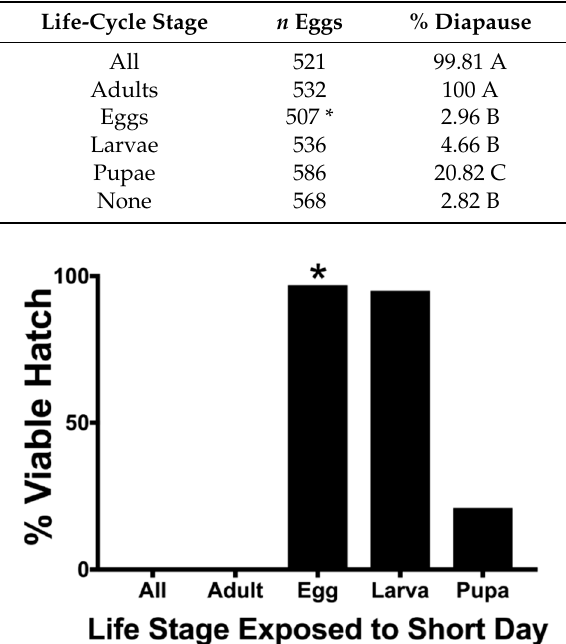
Figure 2. Effect of a short-day photoperiod (8 L:16 D) on Ae. j. japonicus F 2 life stages on F 3 percent hatch. All other F 2 life-cycle stages were exposed to a long-day photoperiod (14 L:8 D). * = eggs of the F 2 generation were tested for percent diapause.